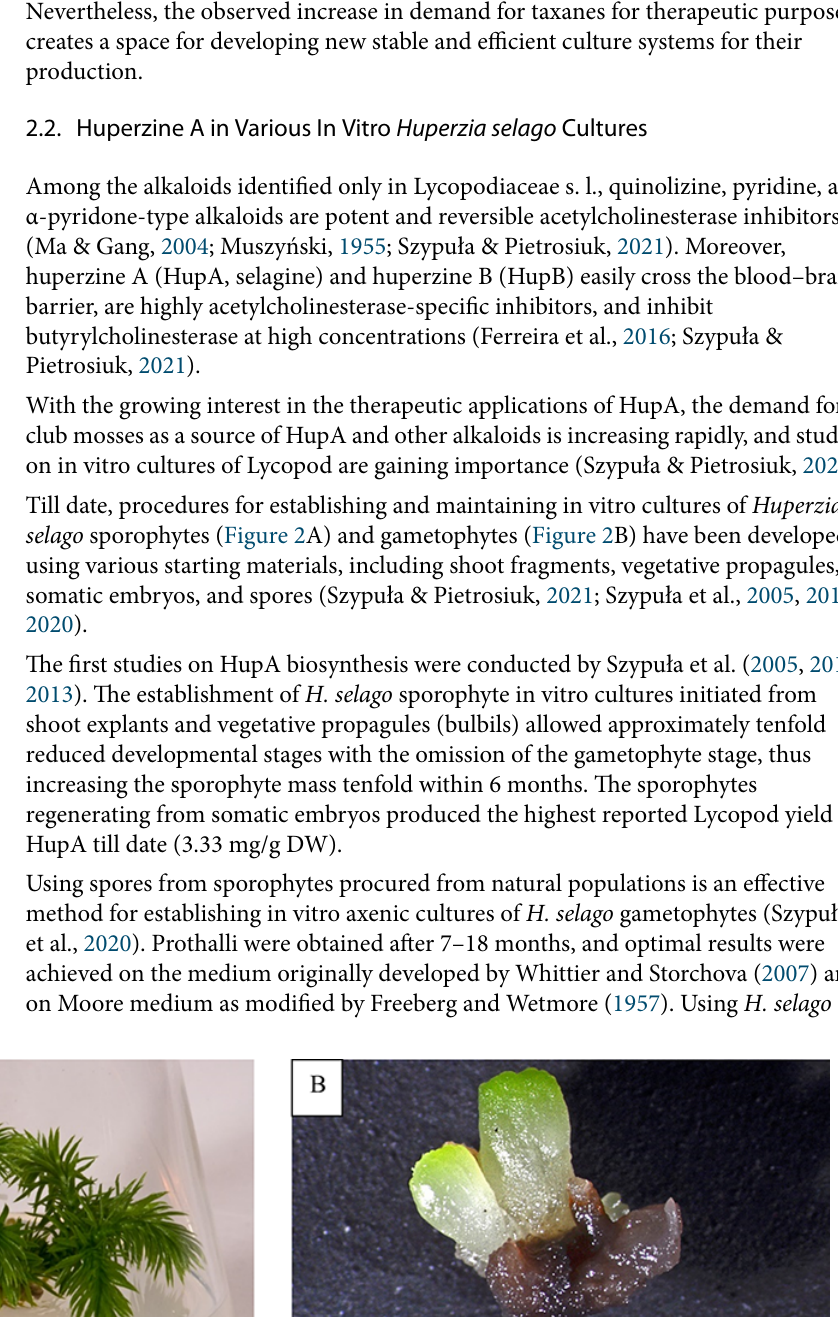
ActaSocietatisBotanicorumPoloniae / 2022 / Volume 91 / Article 9110 Publisher: Polish Botanical